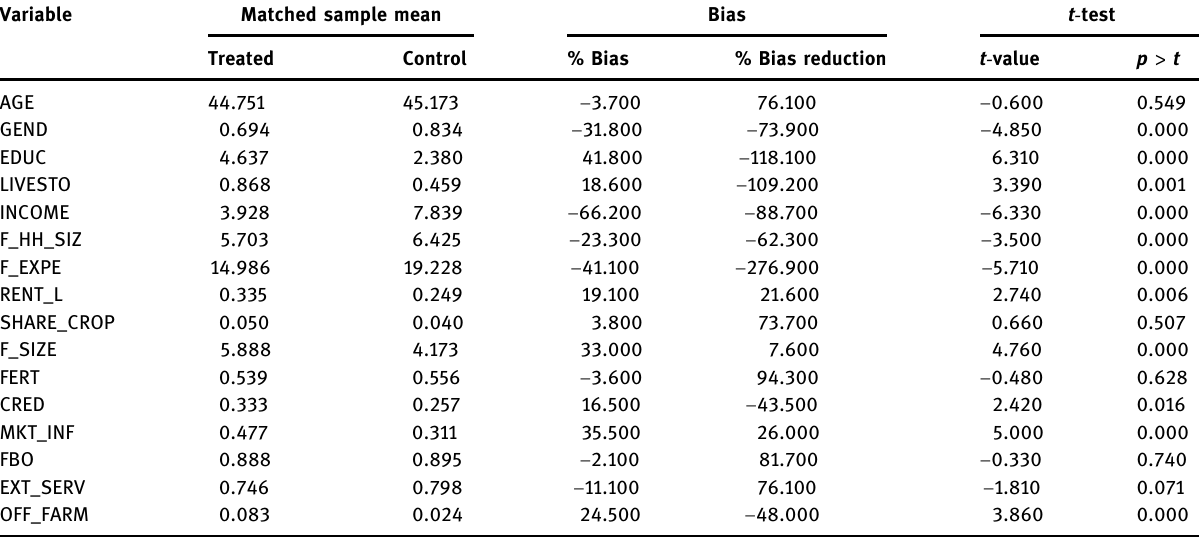
Table 6: Tests for selection bias after matching Variable Matched sample mean Bias t - test